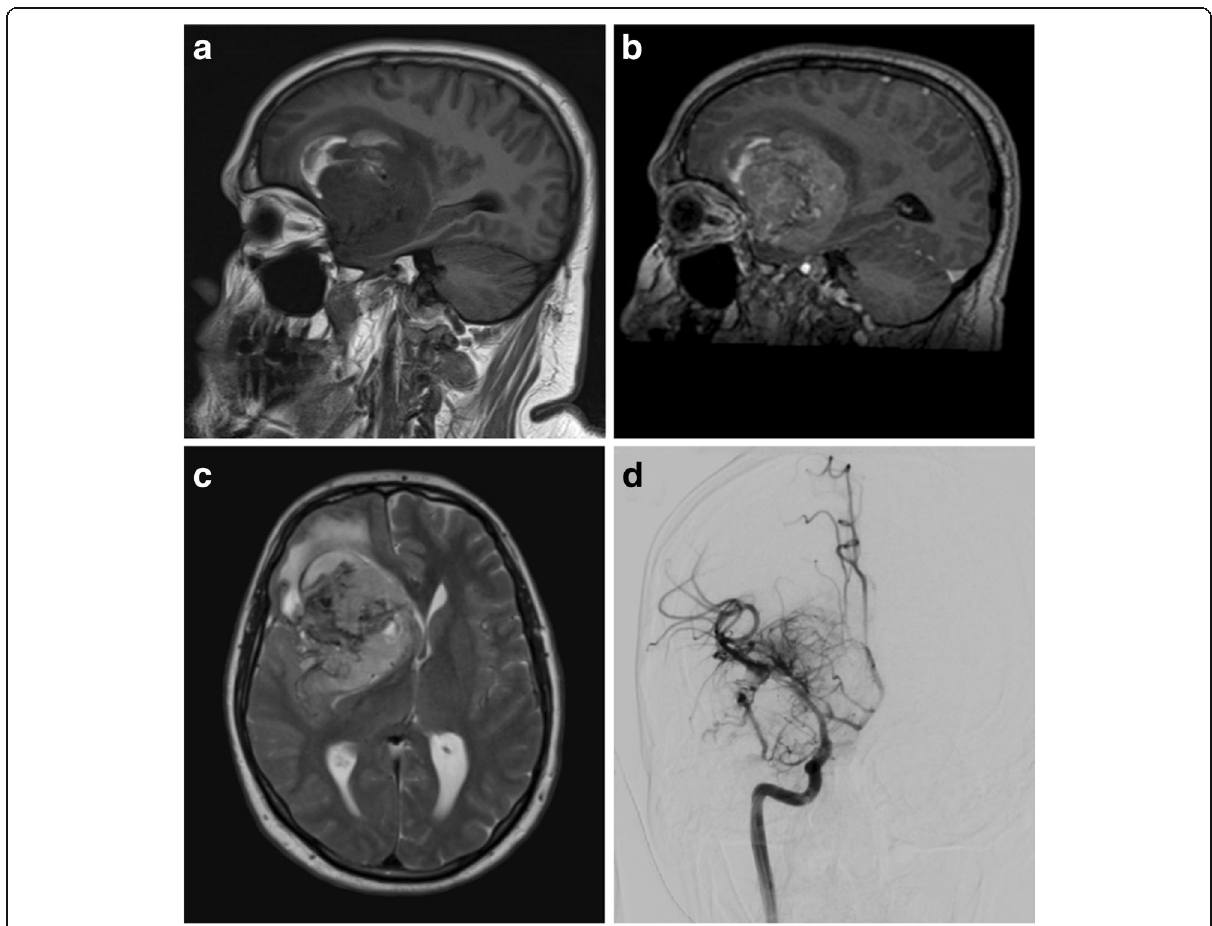
Fig. 10 Glioblastoma. a , b Pre- and post-contrast sagittal T1-weighted MR images showing a vascular and heterogeneously enhancing lesion with areas of internal necrosis and haemorrhage. c T2-weighed axial MR image of the same lesion showing internal flow voids, an apparent thin CSF cleft and a small amount of perilesional oedema. d Selective right internal carotid artery angiogram demonstrates a highly vascular